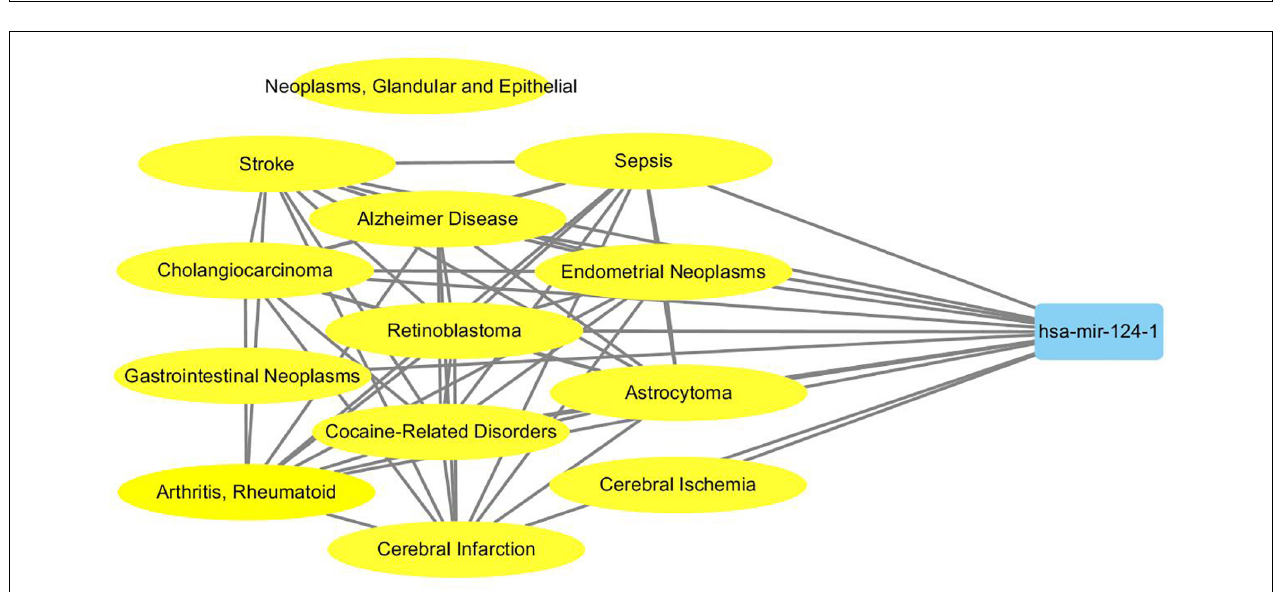
FIGURE 3 | An example of miRNA module detected by MDN-NMTF2 on HMDD2.0-Yan Dataset. The figure shows that all 36 miRNAs in the module are related to Leukemia Myeloid Acute.